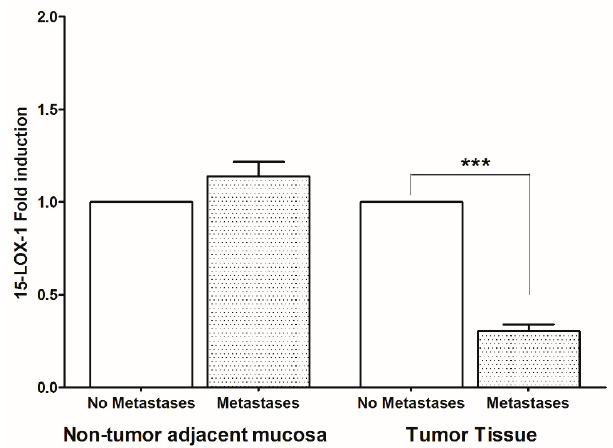
Figure 3. 15-lipoxygenase-1 (15-LOX-1) gene expression levels (mean ± SD) in non-tumor adjacent mucosa and tumor tissue from colorectal cancer patients with and without metastases. Data are expressed as Fold induction. *** p < 0.005 (Student’s t -test).